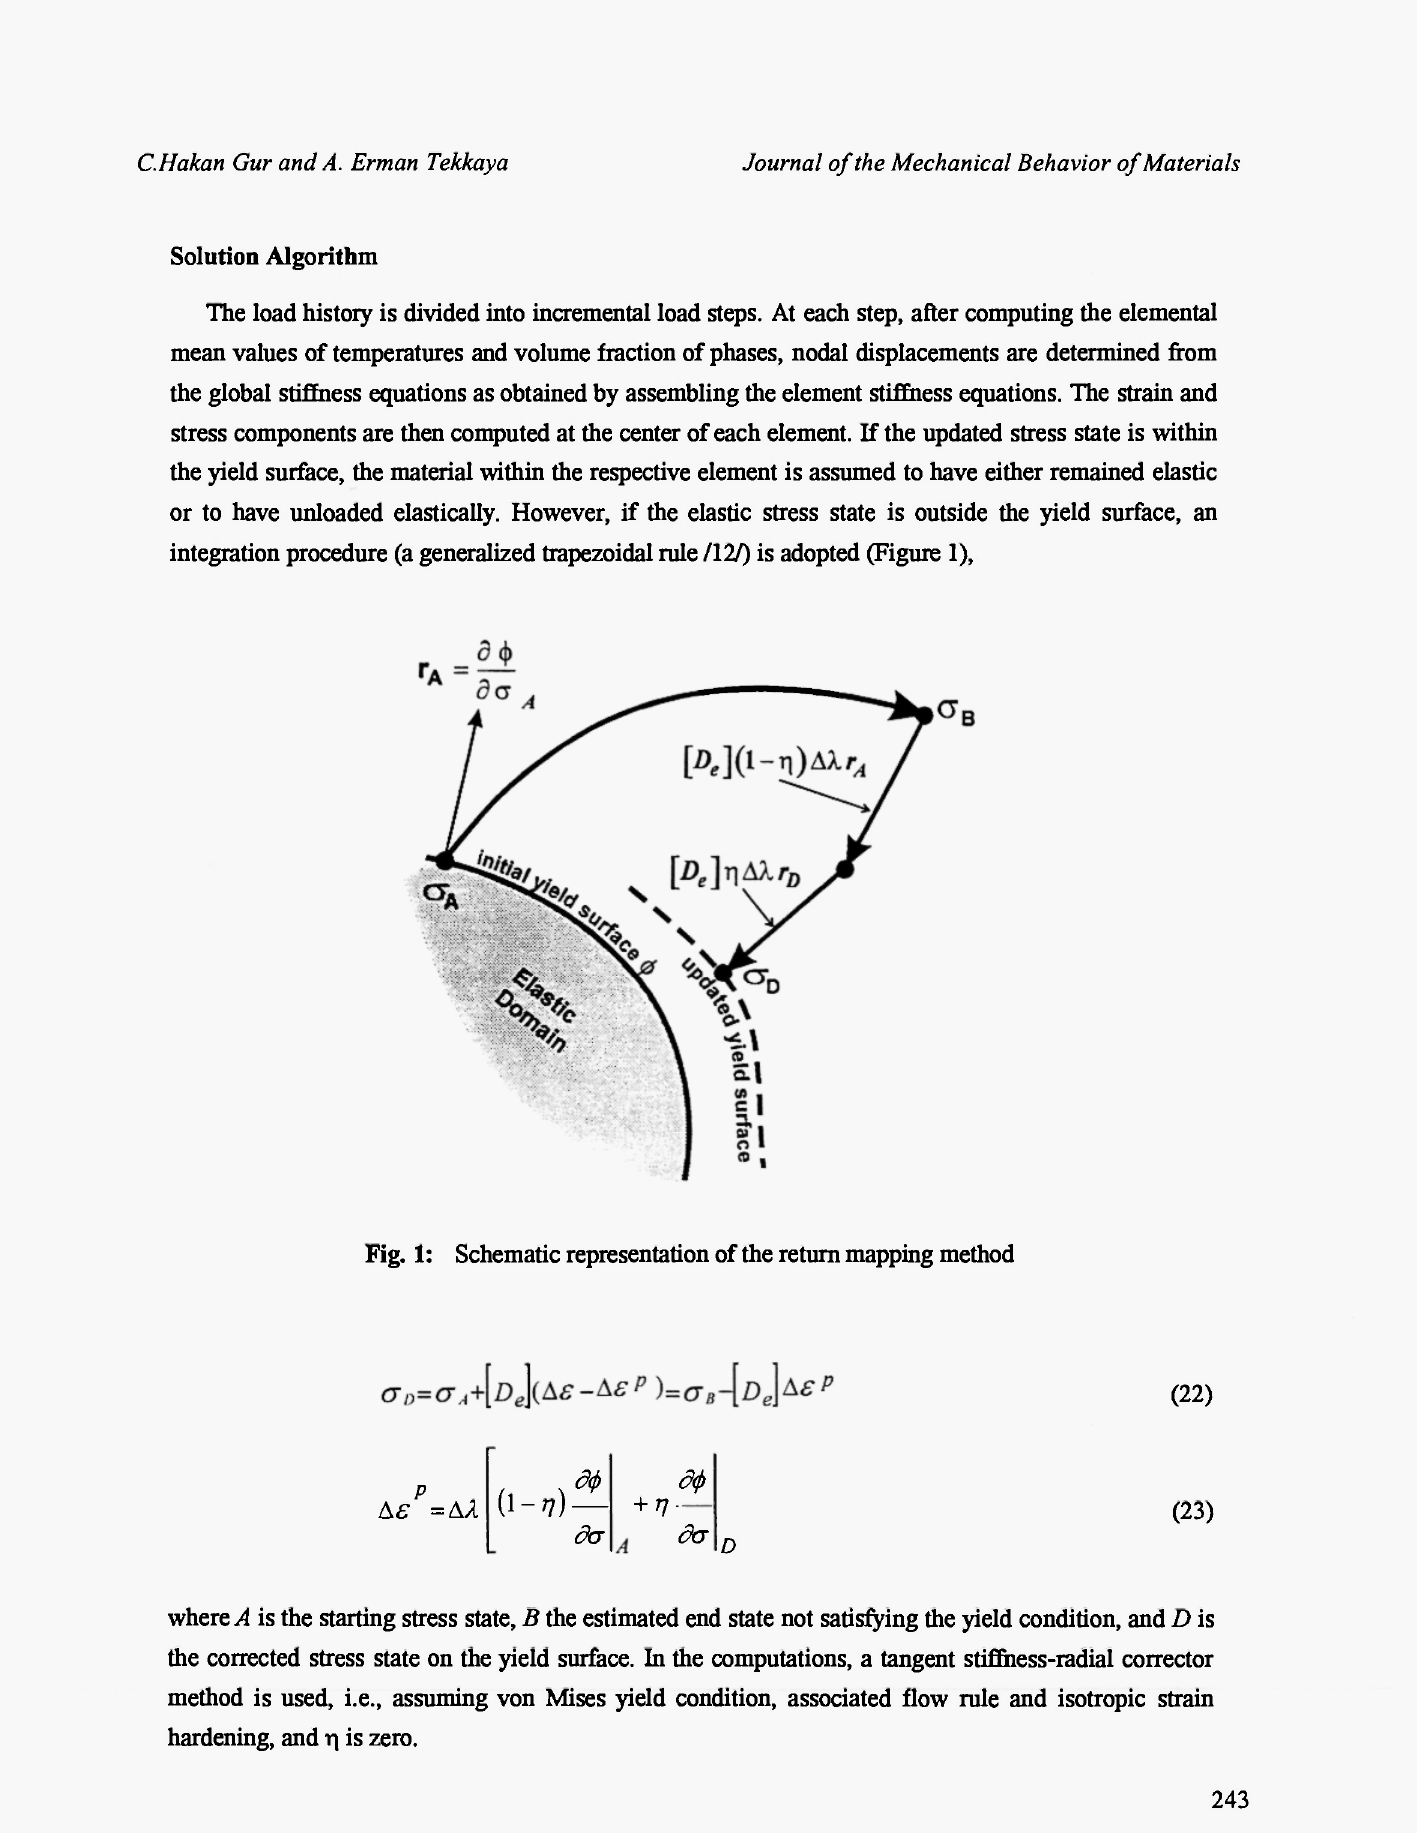
Fig. 1: Schematic representation of the return mapping